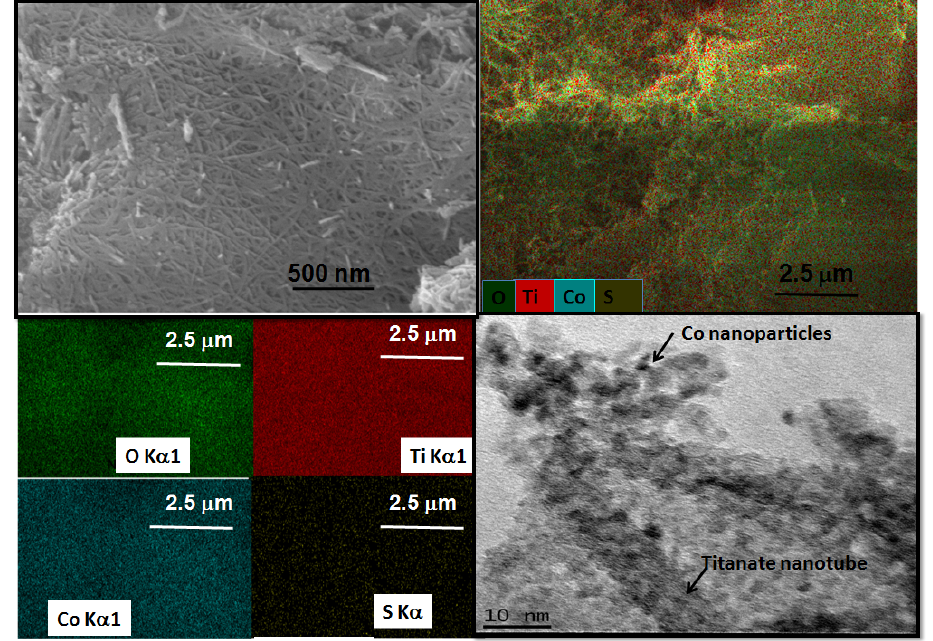
Figure 9. SEM-EDS and TEM images of CoNT spent titanate nanotubes catalyst characterizations. Reaction conditions: amount of the catalyst, 0.15 g; reaction gas mixture, 500 ppm of NO, 1000 ppm of CO and balance in He; flow rate, 80 mL · min − 1 ; space velocity, 48,000 h − 1 . Either 10 wt% ( v/v ) of water vapor or 50 ppm of SO 2 (or both) was used during the reaction at 250 ◦ C for 6 h.